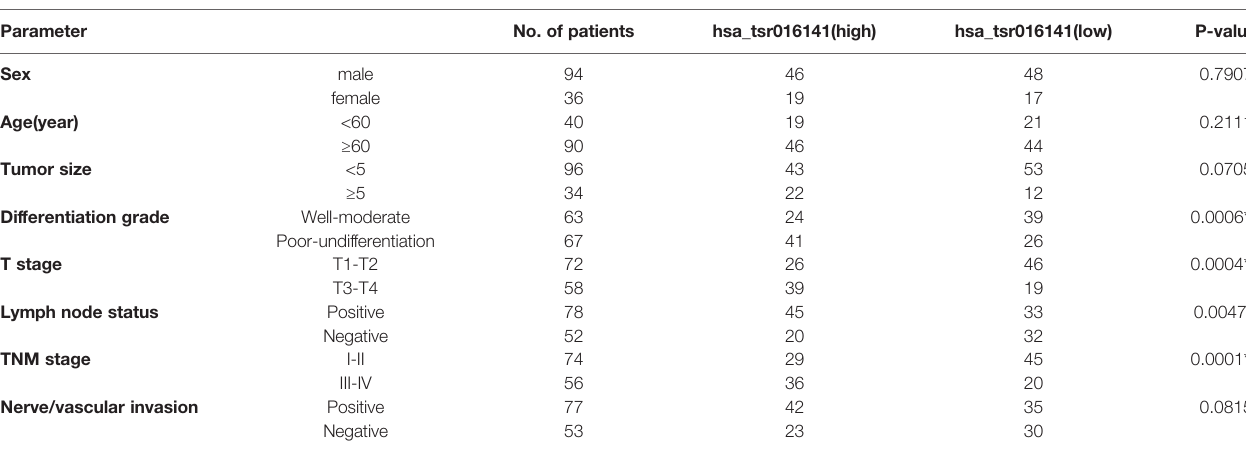
TABLE 6 | Clinicopathological analysis of